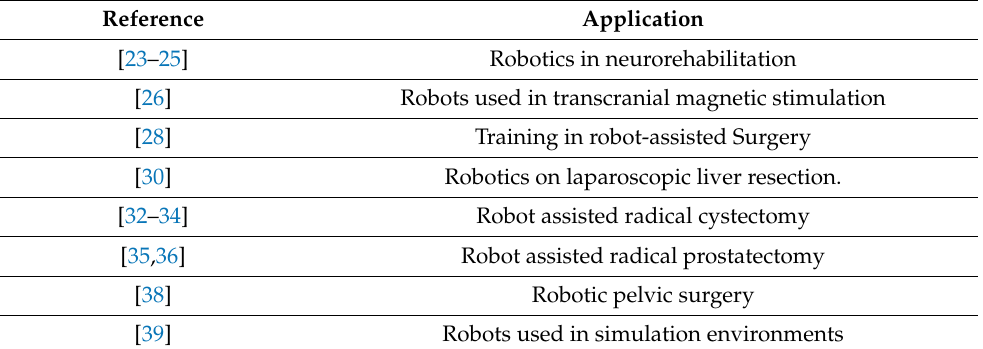
Table 1. Application of the consensus conference in